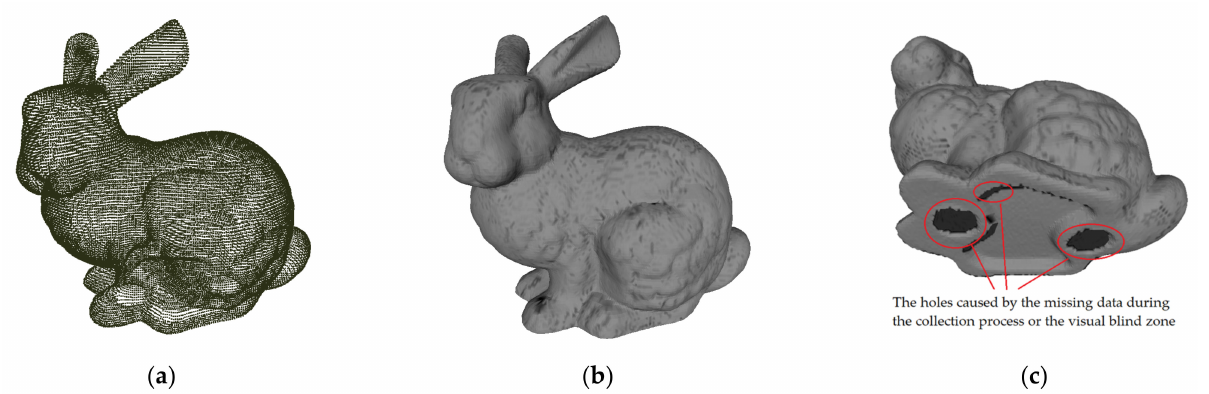
Figure 6. The classical Stanford Bunny: ( a ) original digital point cloud containing only spatial coordinate information; ( b ) point cloud containing a variety of 3D information after 3D reconstruction; ( c ) the holes caused by the missing data during the collection process or the visual blind